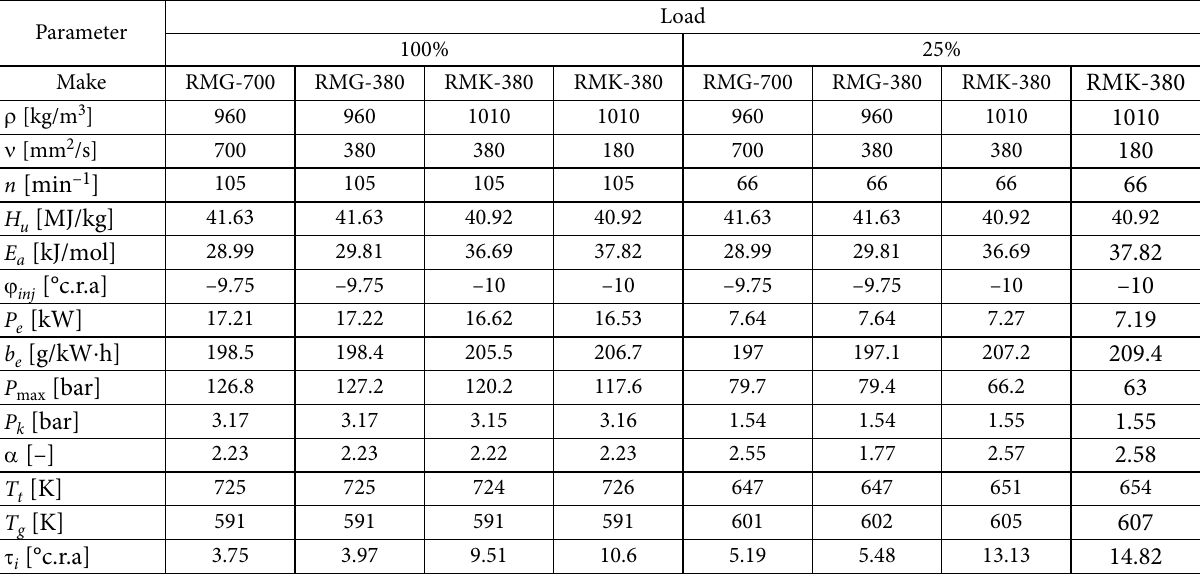
Table B1. Influence of MBF properties on diesel engine MAN B&W 6S60MC parameters